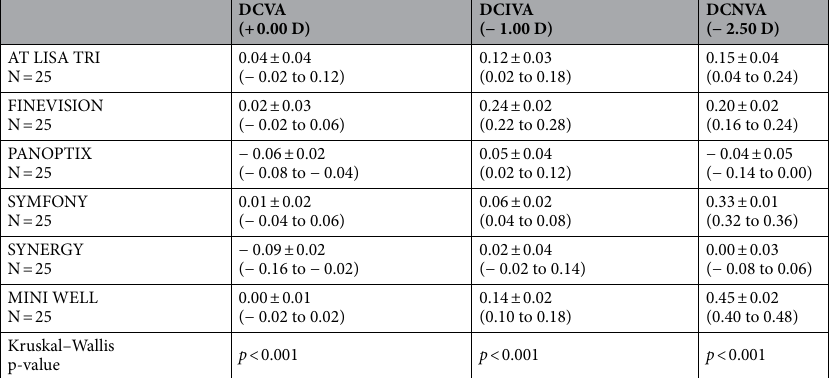
Table 2. Summary of post-operative best-corrected visual acuity obtained by defocus curves for far, intermediate and near distance of the six IOL subgroups analyzed in the current study. Visual acuity was expressed in logMAR scale. DCVA: distance corrected visual acuity for vergence zero; DCIVA: distance corrected intermediate visual acuity for vergence − 1.00 D; DCNVA: distance corrected near visual acuity for vergence − 2.50 D.